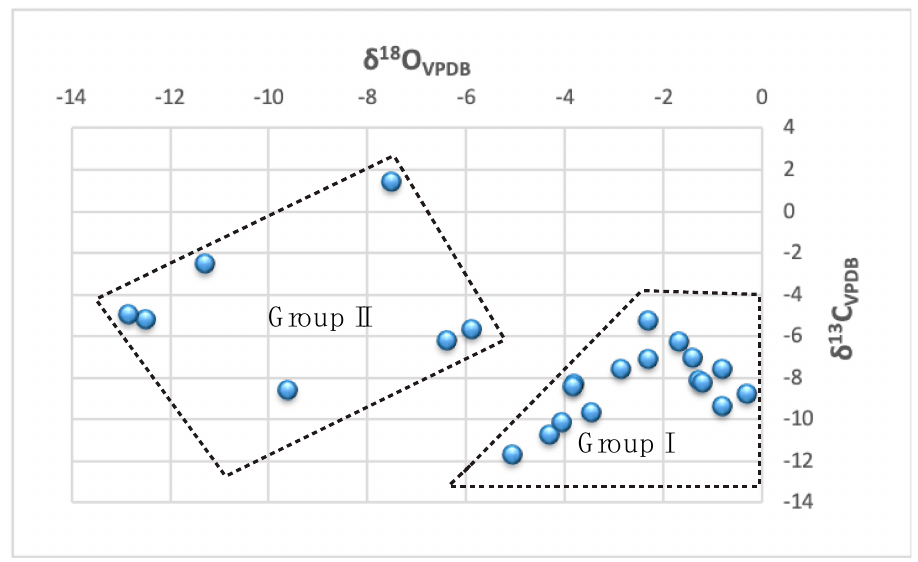
Figure 8. Oxygen and carbon isotope compositions in the Barsarin formation (n = 24). The values are populated on two groups: the first, group I (evaporitic mudstones and wackestones), has heavier values than the second, group II (calcite and dolomite cements). Water 2021 , 13 , x FOR PEER REVIEW